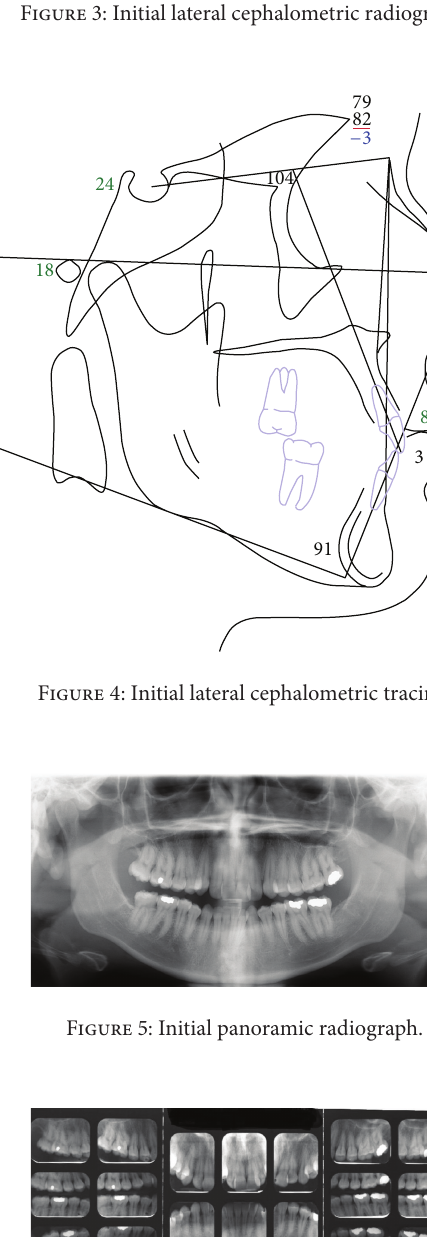
Figure 3: Initial lateral cephalometric radiograph.